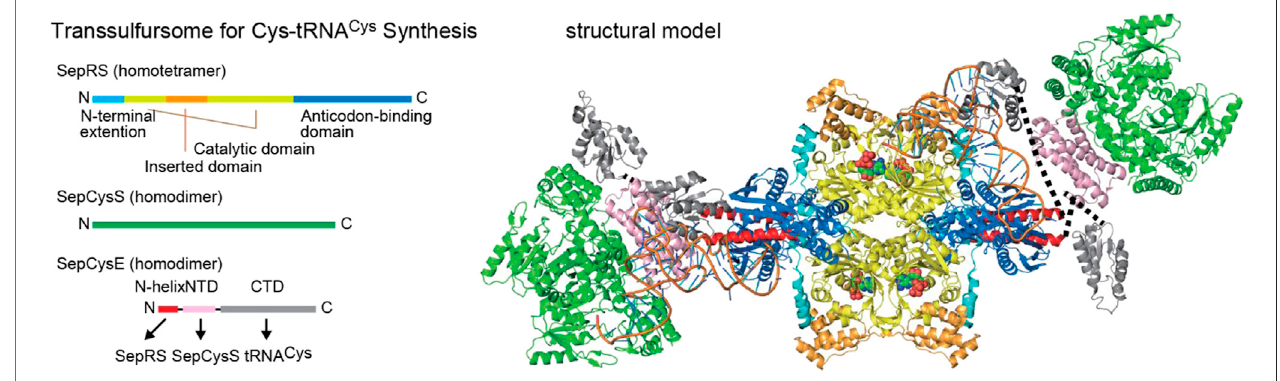
FIGURE 3 | Components and structural model of a transsulfursome [adapted from references (Chen. et al., 2017b) and (Fukunaga and Yokoyama, 2007)] with a color scheme depicting the domain structures. Dotted lines represent fl exible linkers between the two SepCysE domains.